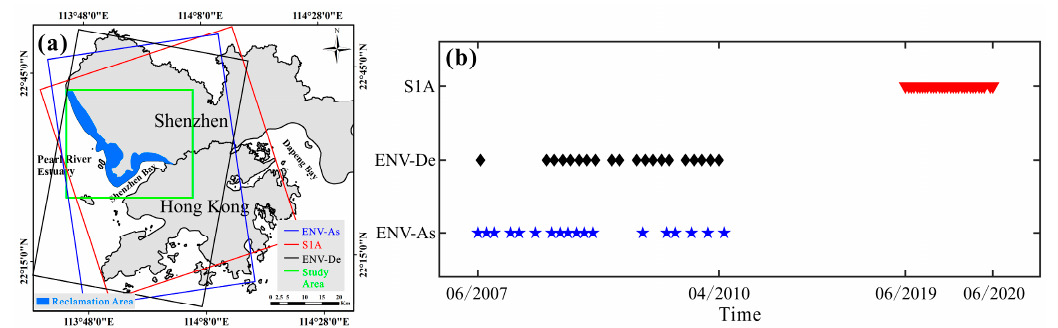
Figure 2. ( a ) Location of Shenzhen, the coverages of the ascending ENV, descending ENV, and Sentinel-1A (S1A) SAR datasets used for Shenzhen are depicted by the green, blue, black and red rectangles, respectively. ( b ) Temporal distribution of those three SAR datasets used for